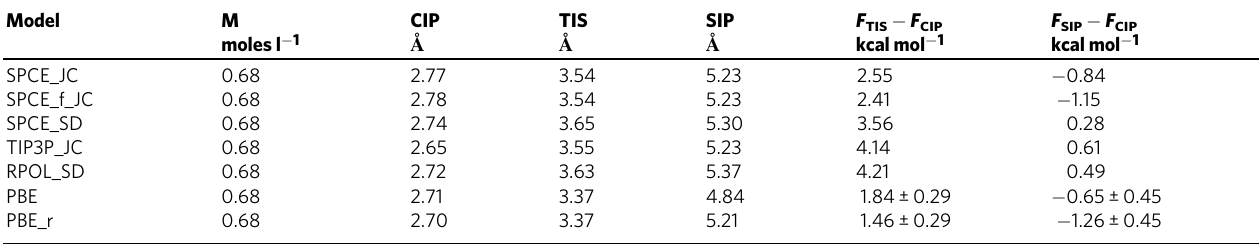
Table 2 Free energy properties.